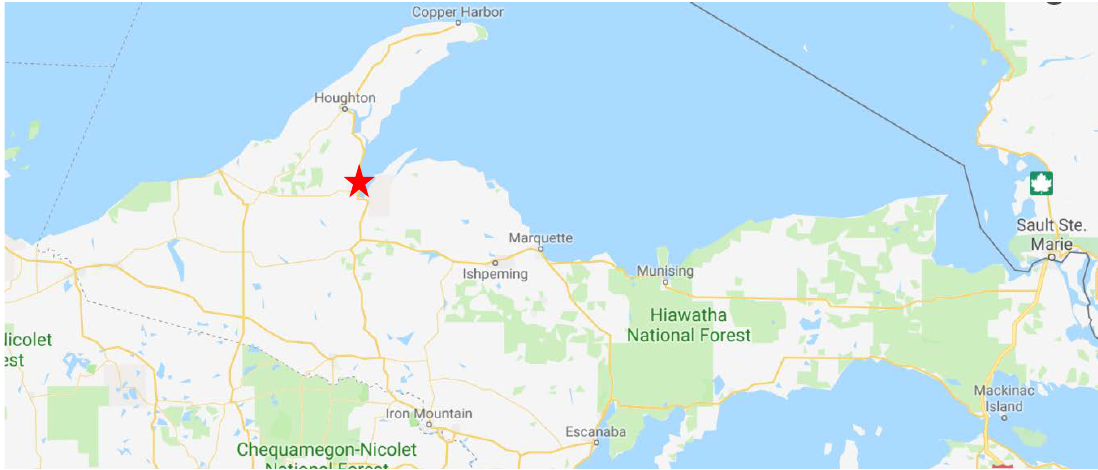
Figure 1. The location of the L’Anse and Baraga villages in the Upper Peninsula.